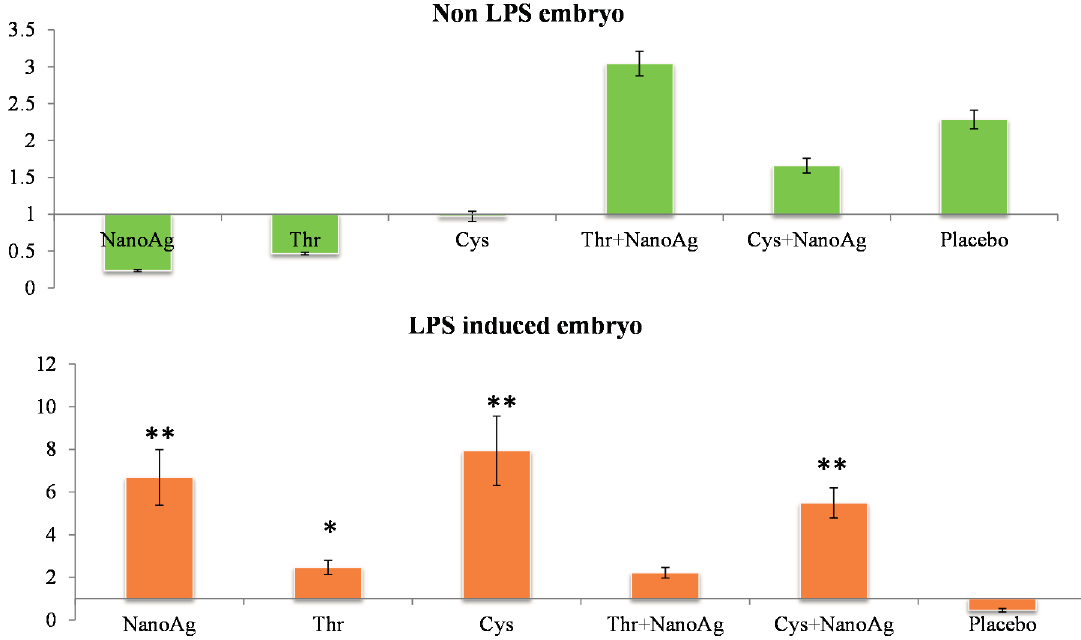
Figure 3. Relative fold expression level of tumour necrosis factor-alpha ( TNF- α ) gene in hepatic tissues of normal (non-LPS) and LPS induced in ovo NanoAg and/or amino acid injected embryos. Expression in uninjected control embryo is taken as 1.0. * and ** indicates significant expression at the level of 95% ( p < 0.05) and 99% ( p < 0.01), respectively.